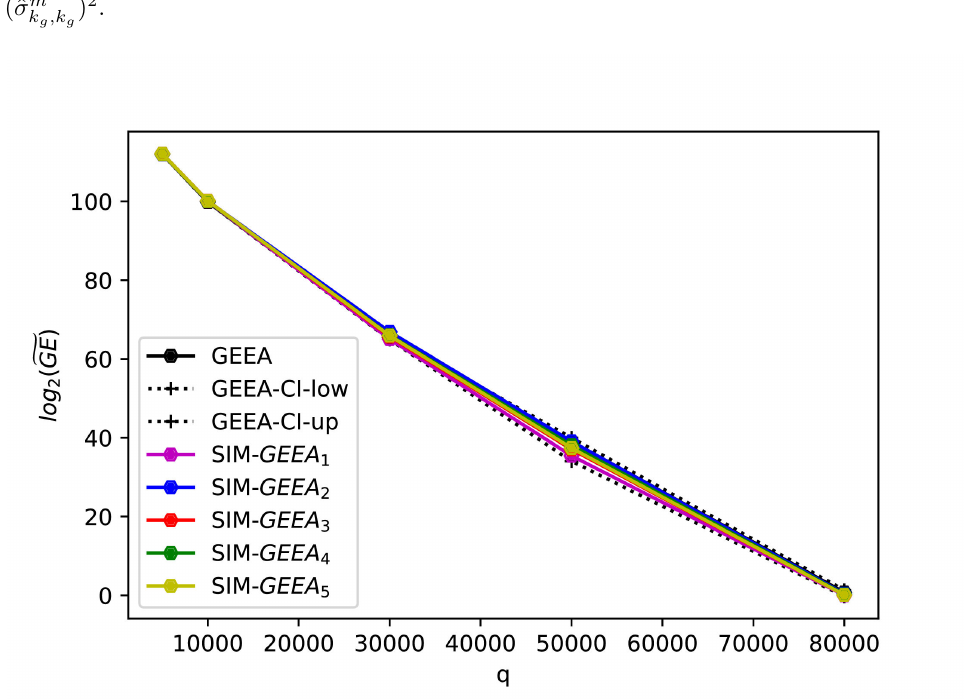
Figure 8: Comparison of Simulated GEEA estimations with confidence bounds of original GEEA estimation on the SGII-1M